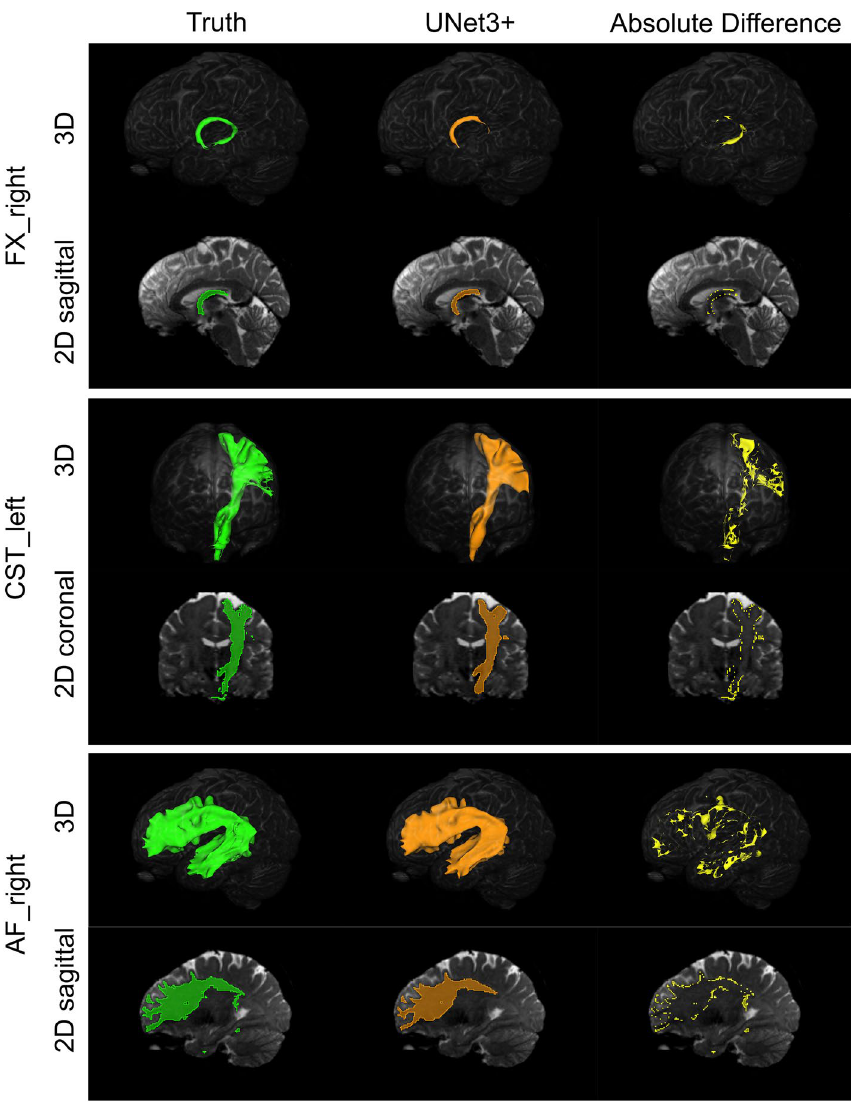
the ground truth segmentation mask, ‘UNet3+ ’ is the output from a fully-trained UNet3+ model, and ’Absolute Difference’ is the absolute difference between ’Truth’ and ’UNet3+ ’. Segmentations are displayed as both 3D volumes and 2D